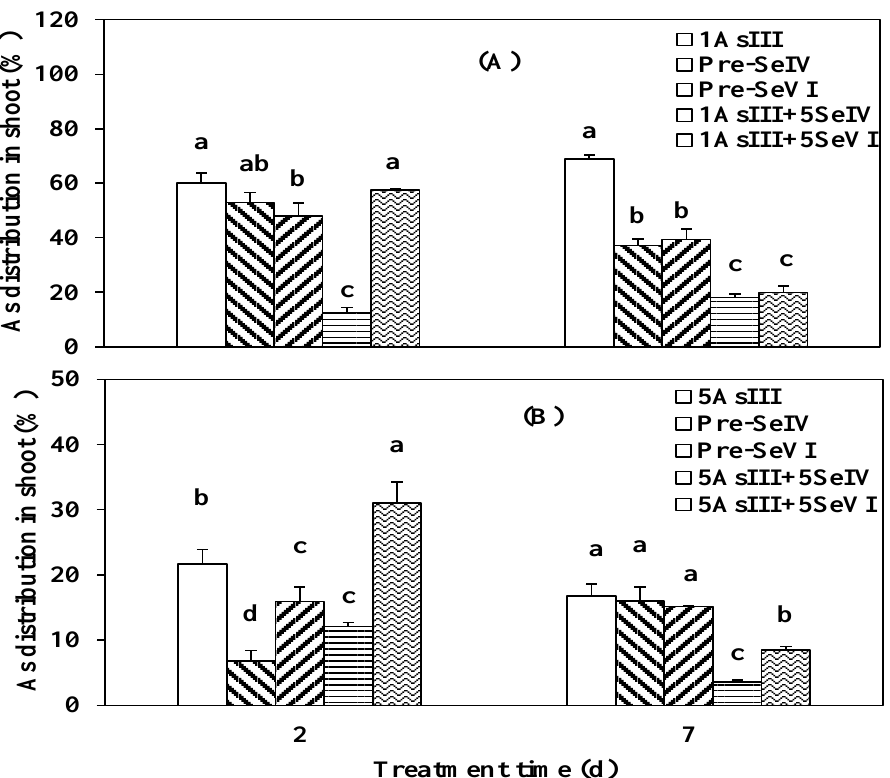
Figure 3. Effect of Se pretreatments and co-application on As translocation in the shoot of rice seedlings exposed to a low ( A ) and high ( B ) concentration of As(III). Data represent mean value ± SE (n = 3). The letters demonstrate statistically significant ( p < 0.05) differences among treatments.